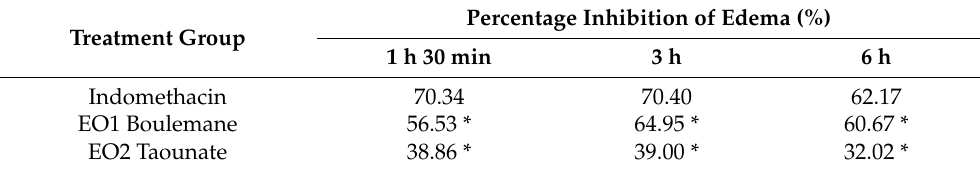
Table 5. Percentage of inflammation inhibition by O. compactum on carrageenan-induced rat paw